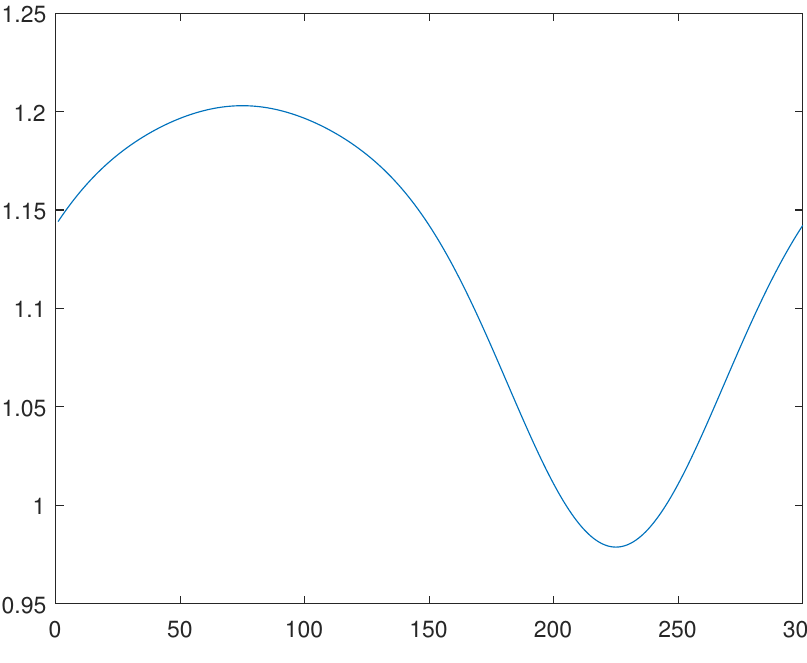
Figure 6. Line 4, solution u 4 ( x ) through the minimization of functional J